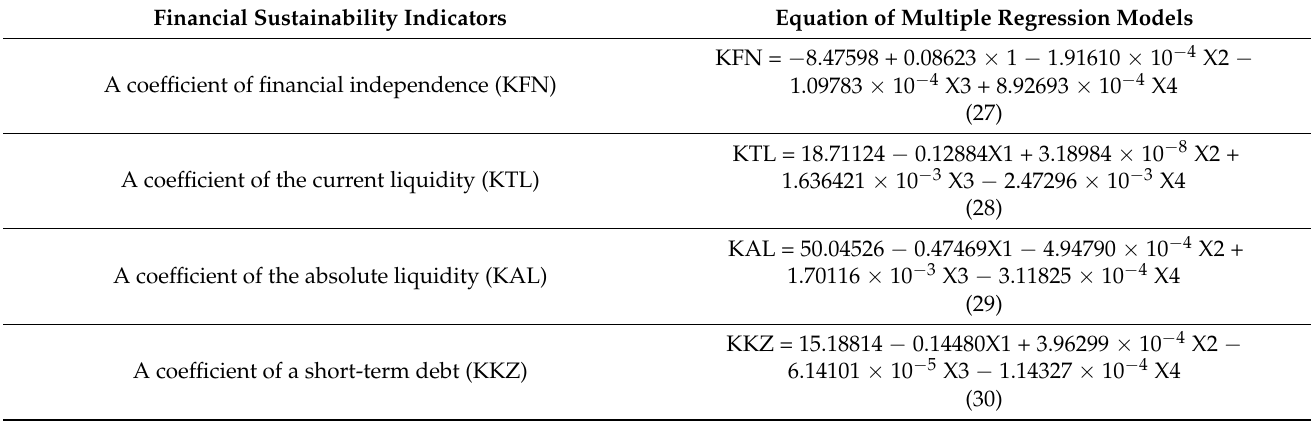
Table 6. Results of creating multiple regression models for the dependence of a company’s financial sustainability indicators.